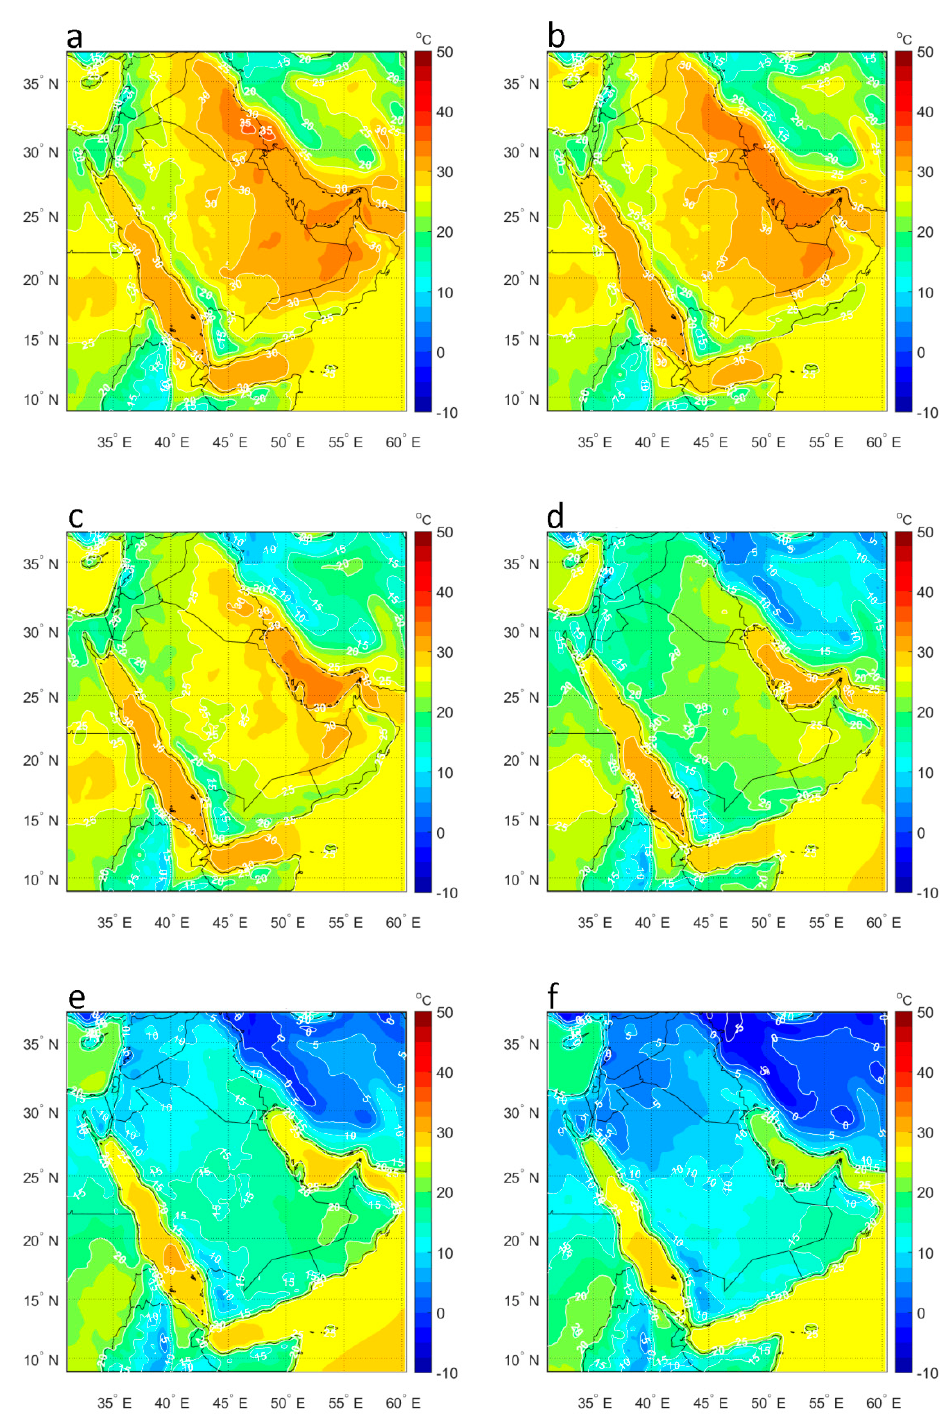
Figure A6. Mean values of daily minimum temperature for the months July to December ( a – f ).